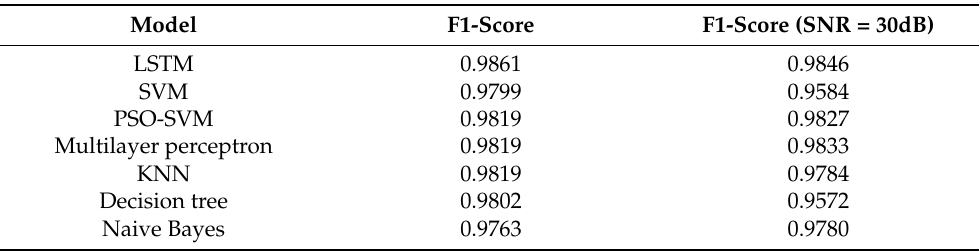
Table 9. F1-score of broken wire signals (simulated signal for training, and simulated signals with Gaussian white noise (SNR = 30dB) for test